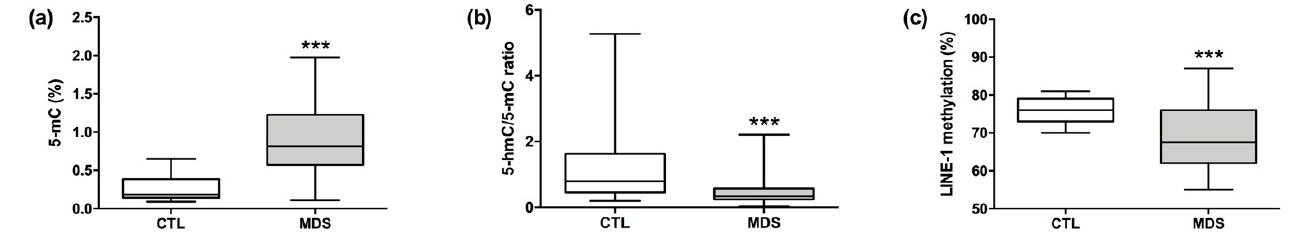
Figure 2. Global and localized DNA methylation statuses in myelodysplastic syndrome (MDS) patients and controls (CTL). Global methylation was determined by the quantification of: ( a ) 5-methylcytosine (5-mC), ( b ) 5-hydroxymethylcytosine (5-hmC)/5-mC ratio, and ( c ) long interspersed nuclear element-1 (LINE-1) methylation. ***, p < 0.001. Table 3. Methylation frequency of studied genes on myelodysplastic syndrome patients, their subtypes, and controls.